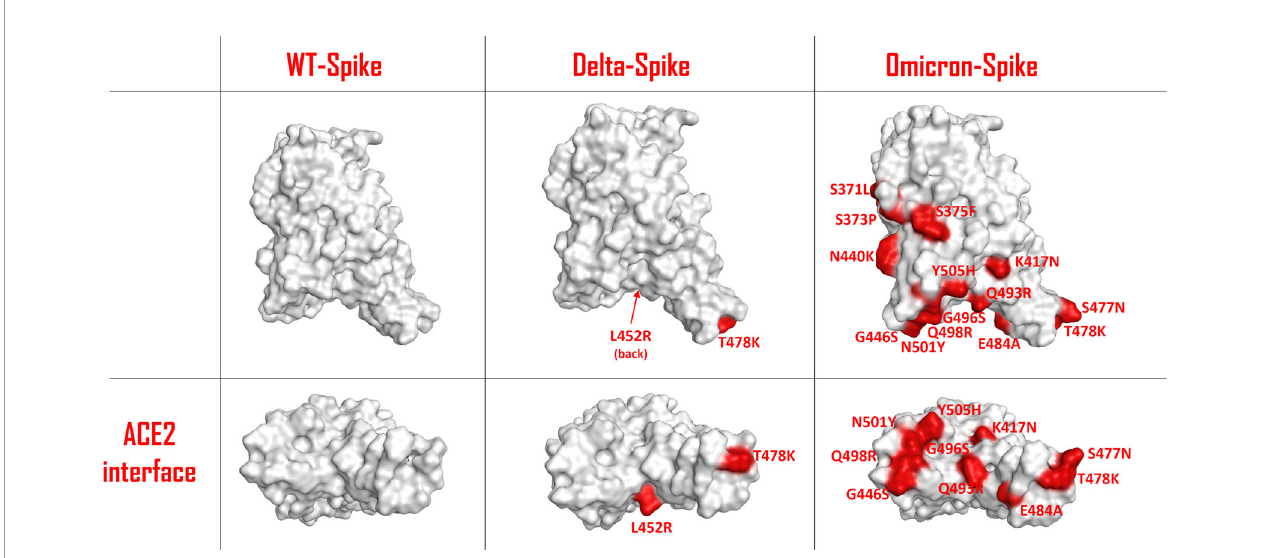
FIGURE 1 | Schematic representation of the SARS-COV-2 Spike protein receptor-binding domain (RBD) surface for the wild type (WT), the Delta variant and the Omicron variant. The residues involved in mutations are colored in red and are also labelled. The top panels represent a lateral view of the Spike-RBDs considered, while the bottom panels highlight the protein surface facing the ACE2 interaction interface for each situation